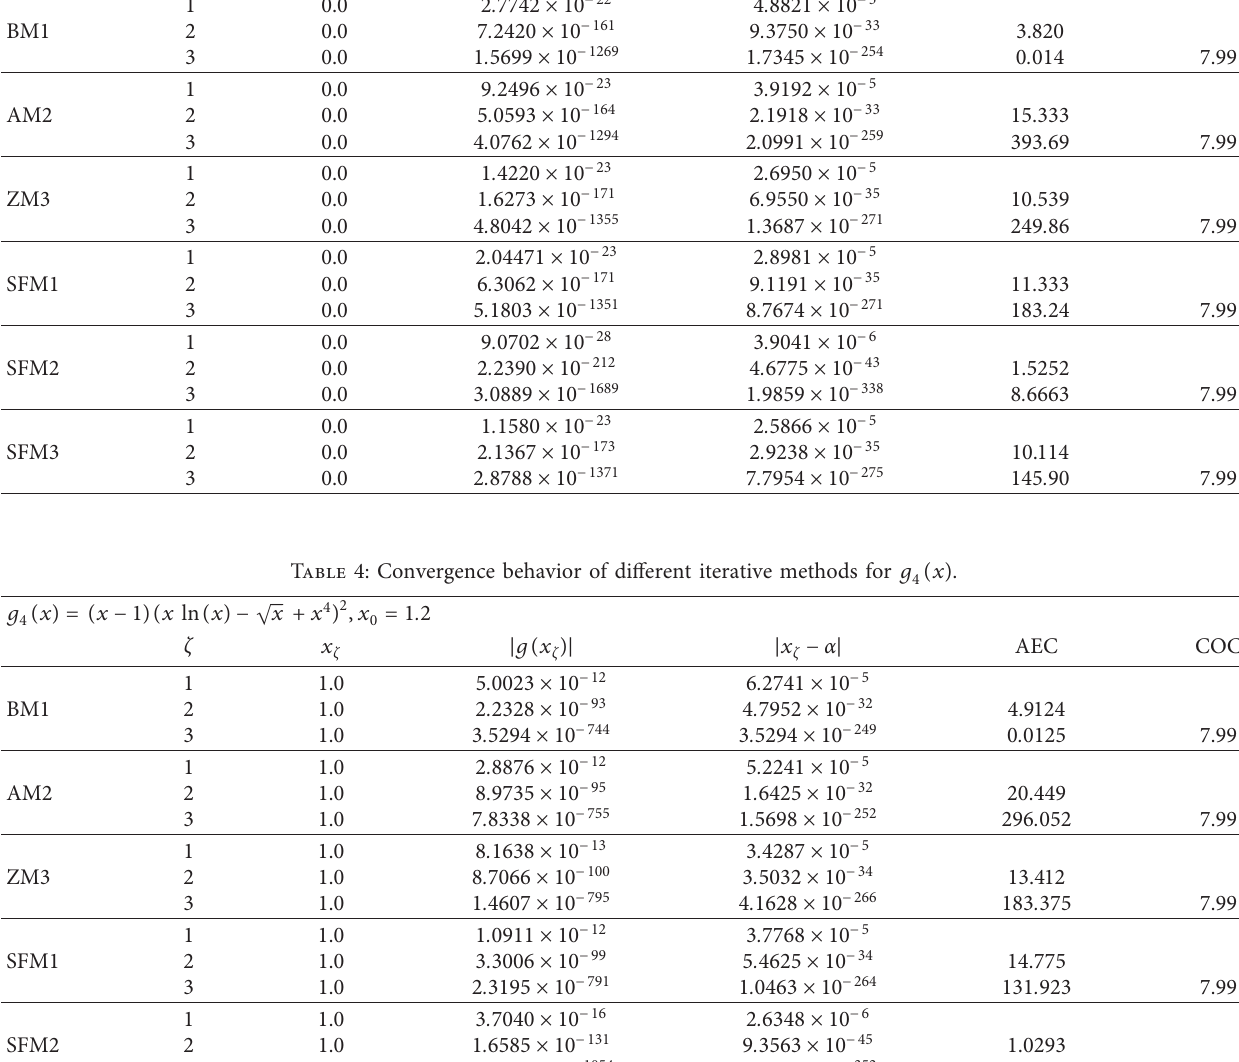
Table 3: Convergence behavior of different iterative methods for g